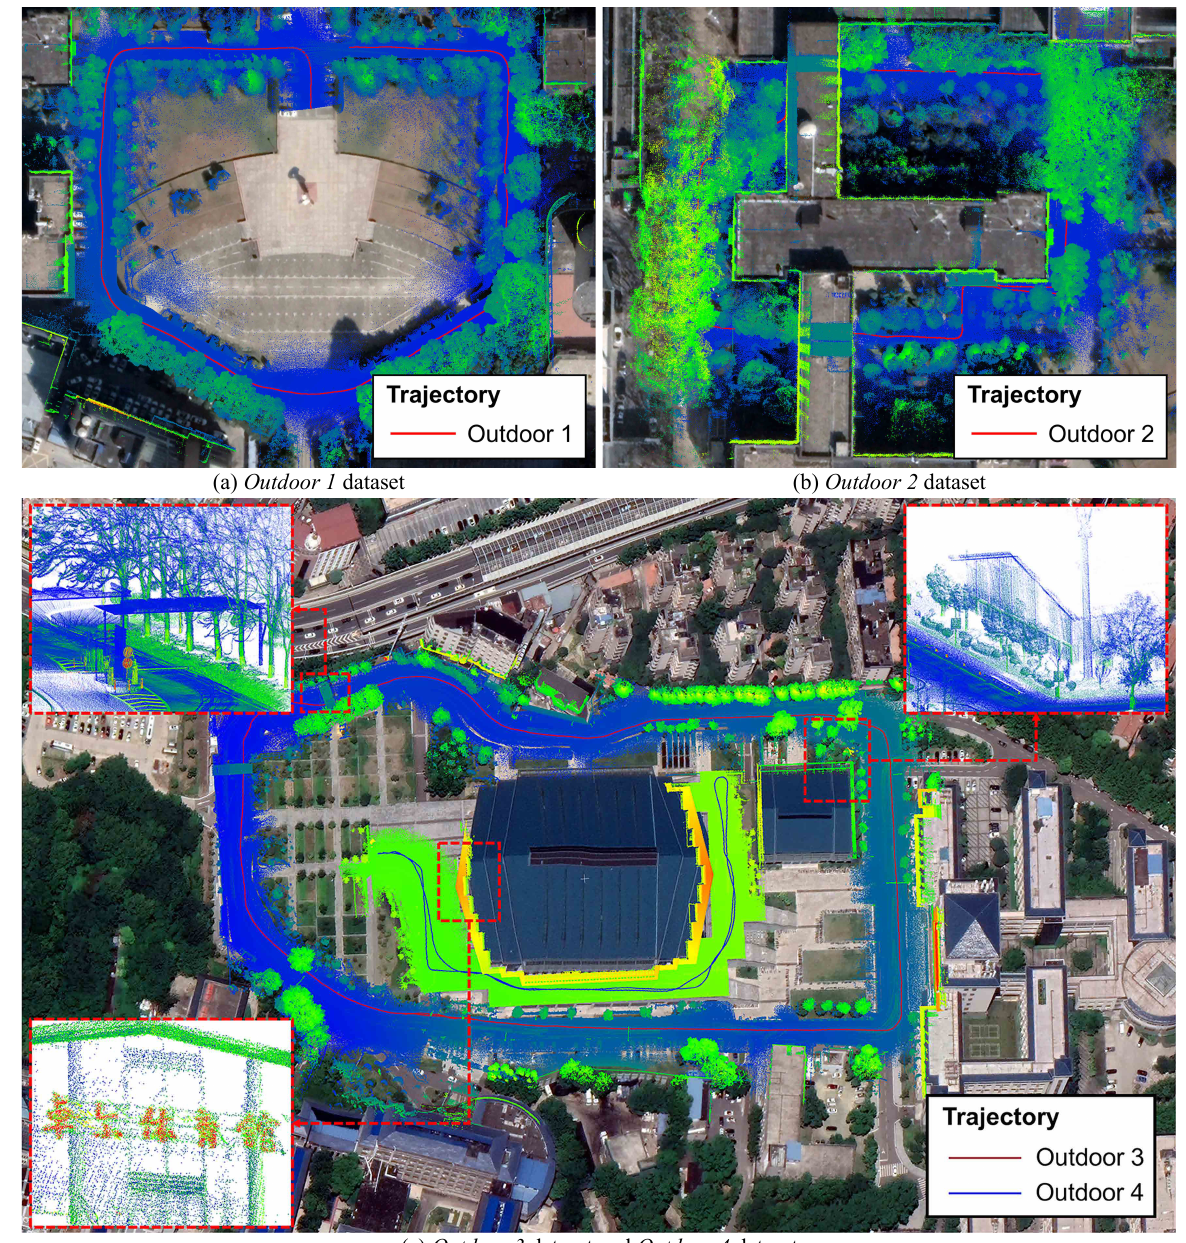
Figure 8. Point clouds aligned with Google Earth